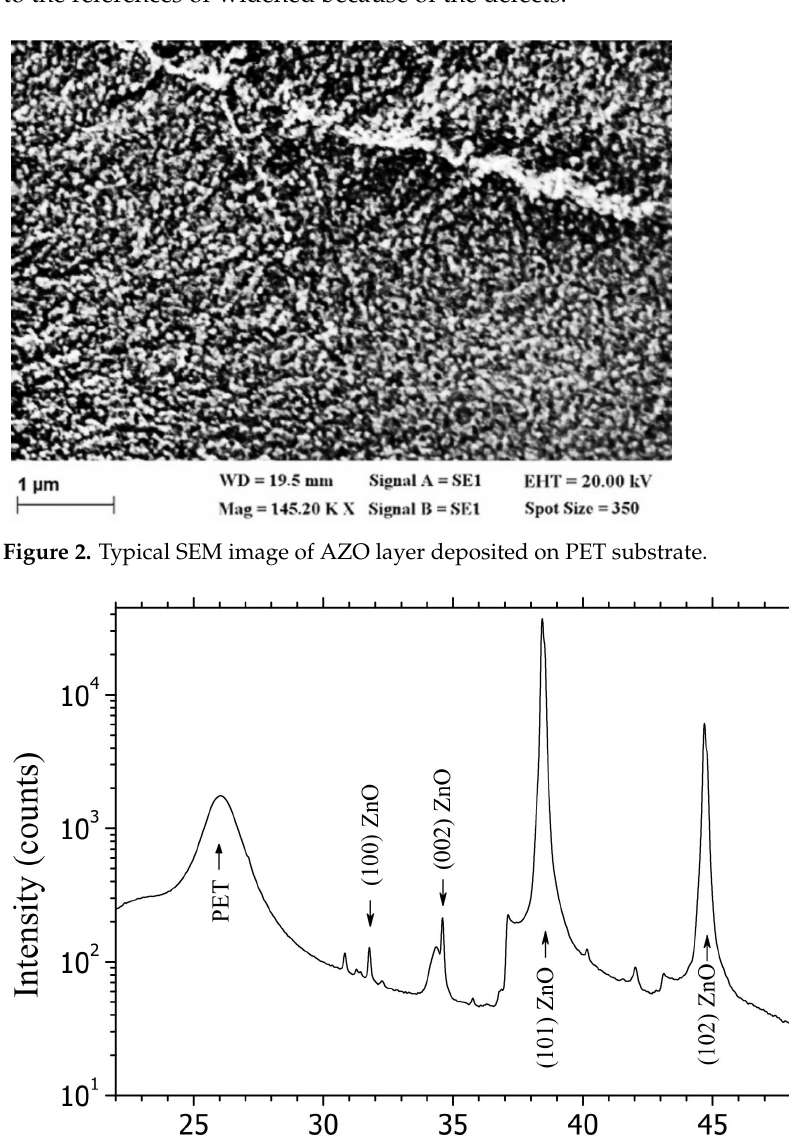
(101) plane [55] and (102) plane [56], respectively, and the weak peak localized at ~32 ◦ to reflections on the (100) plane [57]. The diffraction peaks can be slightly shifted compared to the references or widened because of the defects.